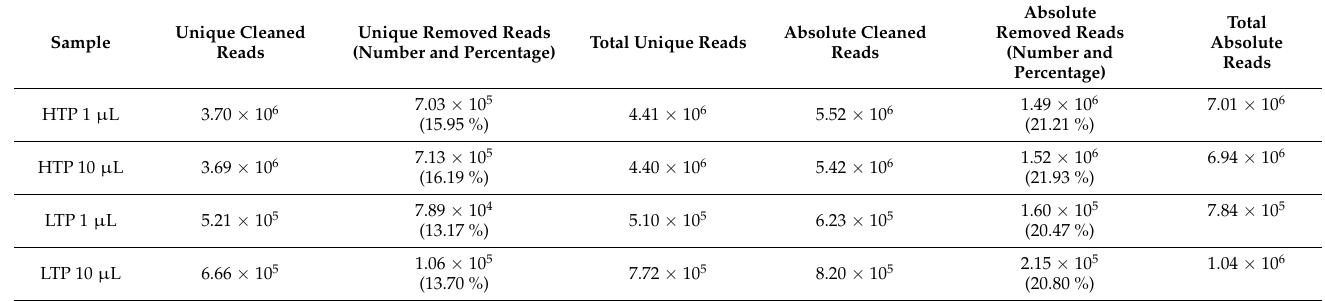
Table 1. Overview of the samples sequenced by different sequencing depths of NGS. The total unique reads refer to the number of reads with different peptide sequences and the total absolute reads refer to the total number of reads that each sample contains. The cleaned reads are the reads left after computational filtering of the sequencing data using a MATLAB script. The cleaned reads were used for all the analyses. HTP: higher-throughput, LTP: